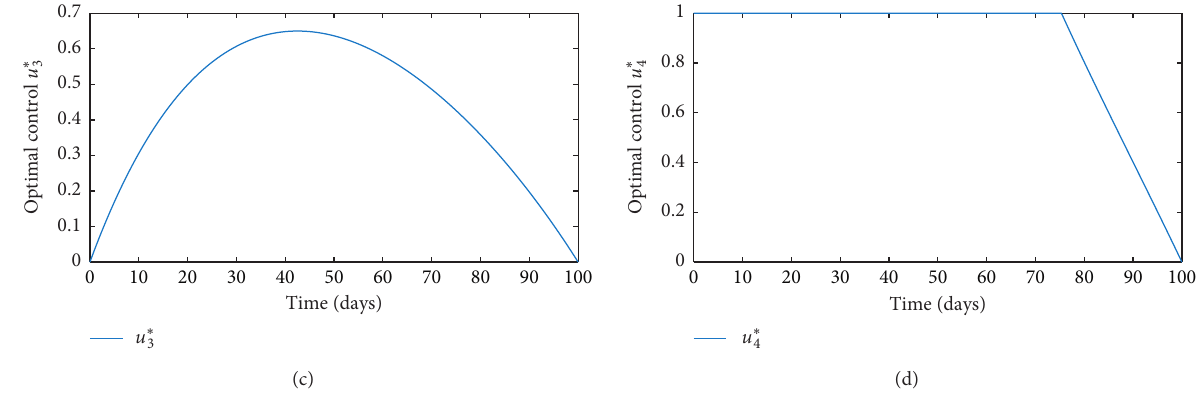
Figure 4: Graphical illustration showing the optimal control functions ( u ∗